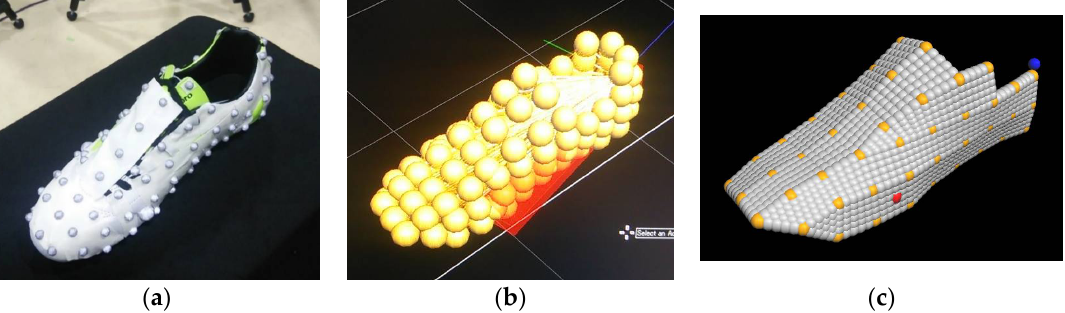
Figure 2. The surface model of foot was made from captured real markers: ( a ) Additional real markers were placed in a grid on impact area (instep and inside); ( b ) Captured real markers; ( c ) Virtual markers were located in surface by filling blanks of captured real markers like linked small panels.